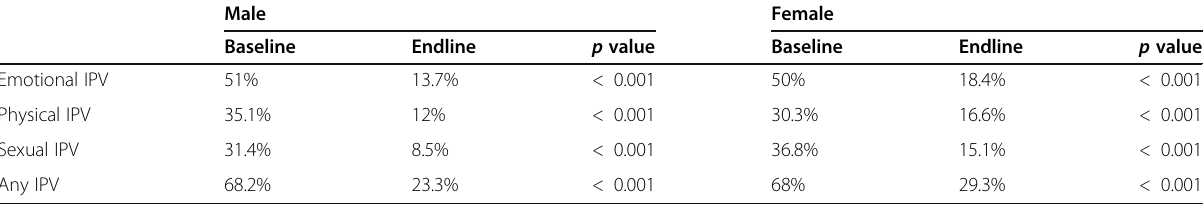
Table 5 IPV in the last 12 months (male perpetration, female experience)